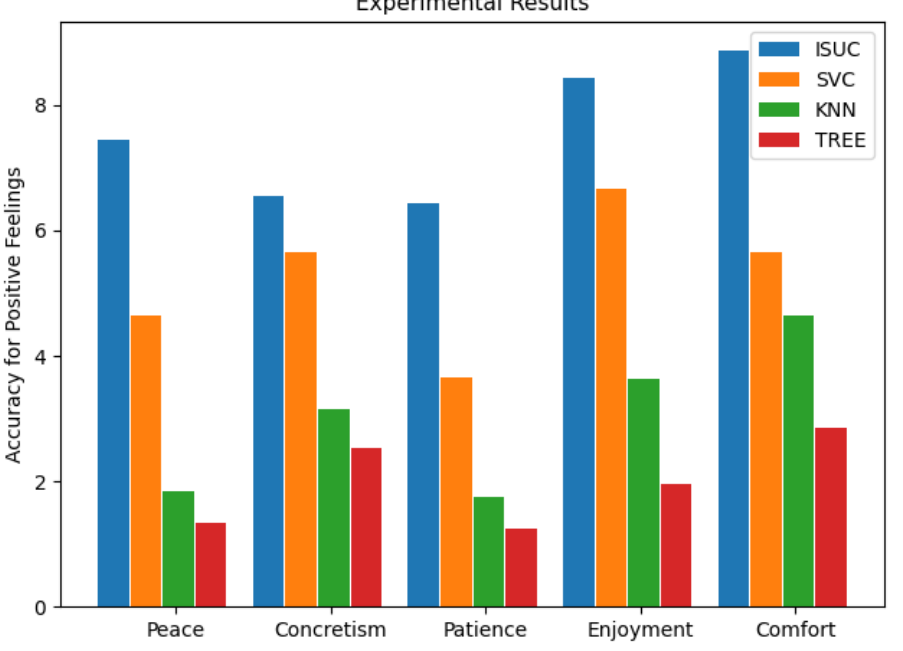
Figure 4. Shows the experimental outcomes for positive